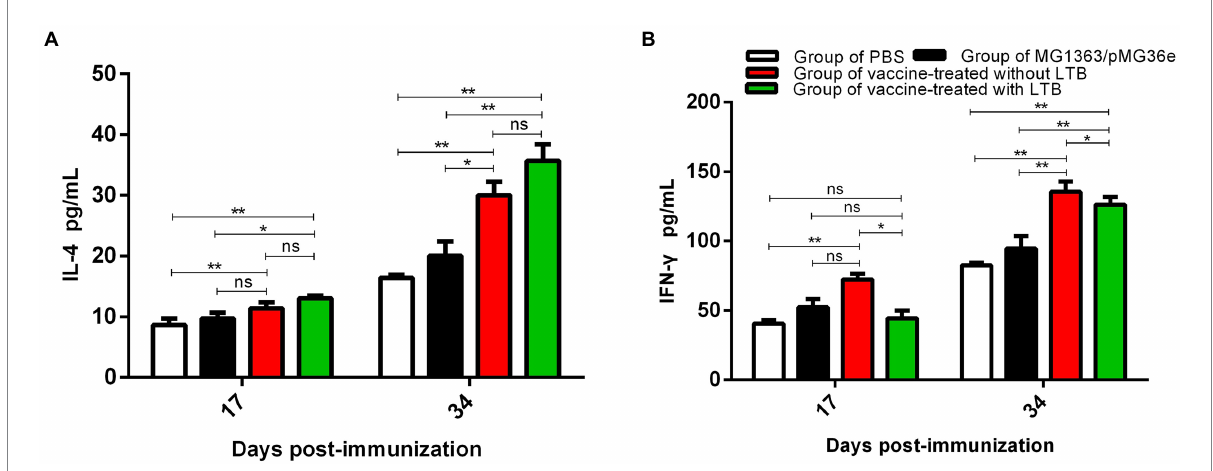
FIGURE 5 The levels of cytokines IL-4 and IFN- γ in serum were measured using ELISA on 17 and 34 dpv. (A) The levels of cytokines IL-4 in sera on 17 and 34 dpv were determined using ELISA. (B) The levels of cytokines IFN- γ in sera on 17 and 34 dpv were measured via ELISA. “**” in the figure means the difference is extremely significant p < 0.01, “*” indicates a significant difference p < 0.05, and “ns” indicates no significant difference p > 0.05.